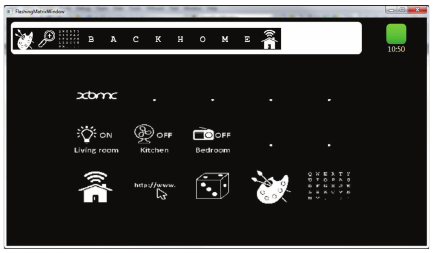
Figure 6: Primary user interface showing the main screen of the Smart Home